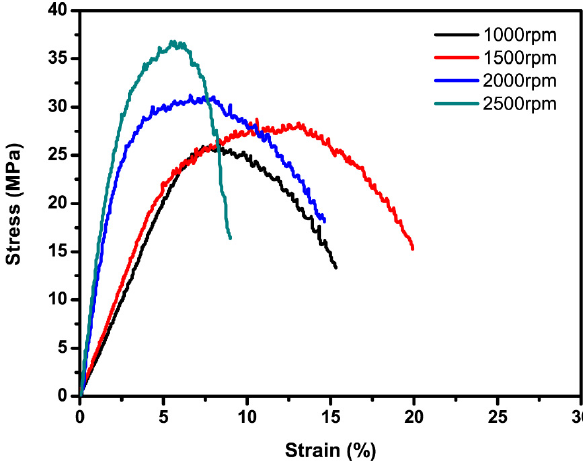
Figure 8: Tensile stress-strain curves with different rotary speeds